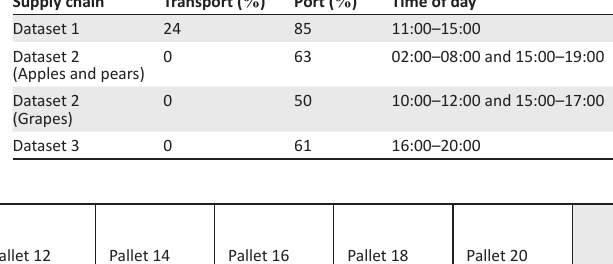
TABLE 2: Summary of cold chain breaks per segment and time of day. Supply chain